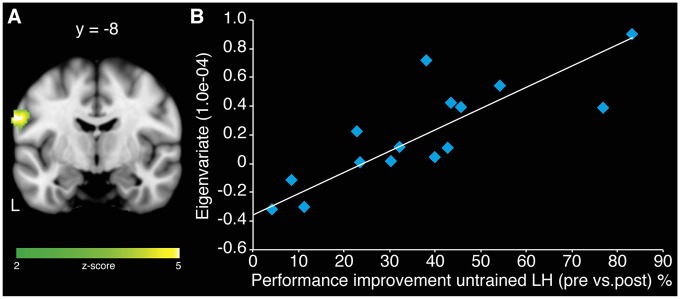
Association of centrality changes in rs-fMRI and relative performance improvements of the untrained LH in the MG. (A) A correlation analysis revealed a significant positive correlation between increase in centrality in left SM1 and behavioral gains of LH for MG. No such correlation could be observed for the CG. (B) Scatter plot diagram illustrating the correlation between the eigenvariate extracted from the peak voxel of the cluster in left SM1 and the performance improvements of the untrained LH in MG (model equation, y = 0.0148x − 0.3617; r = 0.842; p < 0.001).